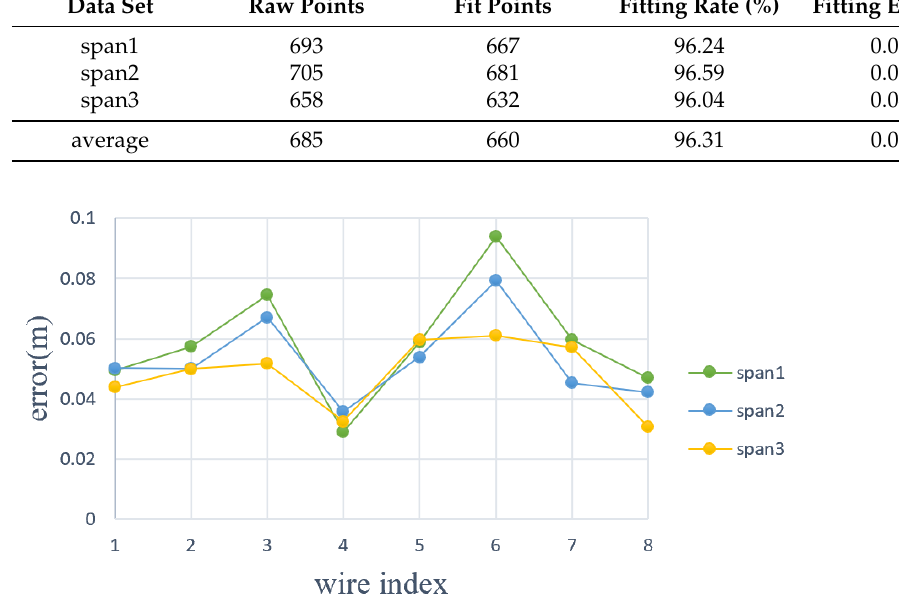
Figure 20. Fitting error for eight wires at each span.